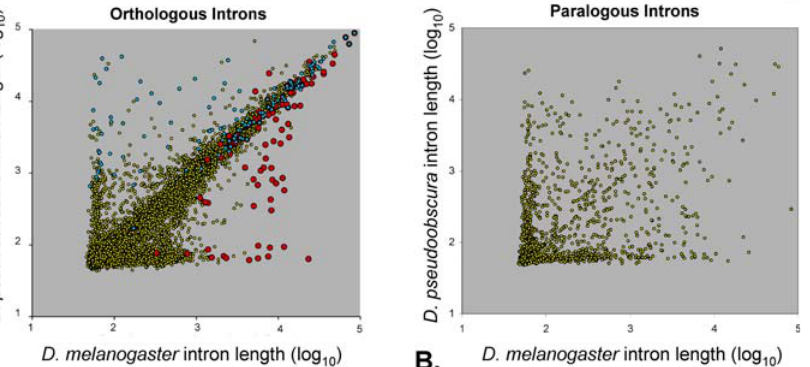
Figure 7. D. melanogaster Intron Lengths Are Highly Correlated with Their Inferred D. pseudoobscura Orthologs; D. melanogaster Paralogous Introns Show No Such Correlation (A) x -axis, length (log 10 ) of annotated D. melanogaster introns; y -axis, length (log 10 ) of their inferred orthologs in the D. pseudoobscura genome. Red circles indicate those introns containing a transposon in D. melanogaster; blue circles indicate those introns containing a transposon in D. pseudoobscura; gold circles indicate introns without identifiable transposons in either species. Spearman correlation coefficient: 0.637; p , 0.001. (B) Intron lengths of paralogs having the same intron–exon structure as judged by the positions of their splice junctions relative to the protein alignments of their reciprocal best-hit best HSPs. x -axis, length (log 10 ) of introns in an annotated D. melanogaster gene; y -axis, length (log 10 ) of corresponding paralogous introns. Spearman correlation coefficient: 0.448; p , 0.001. DOI: